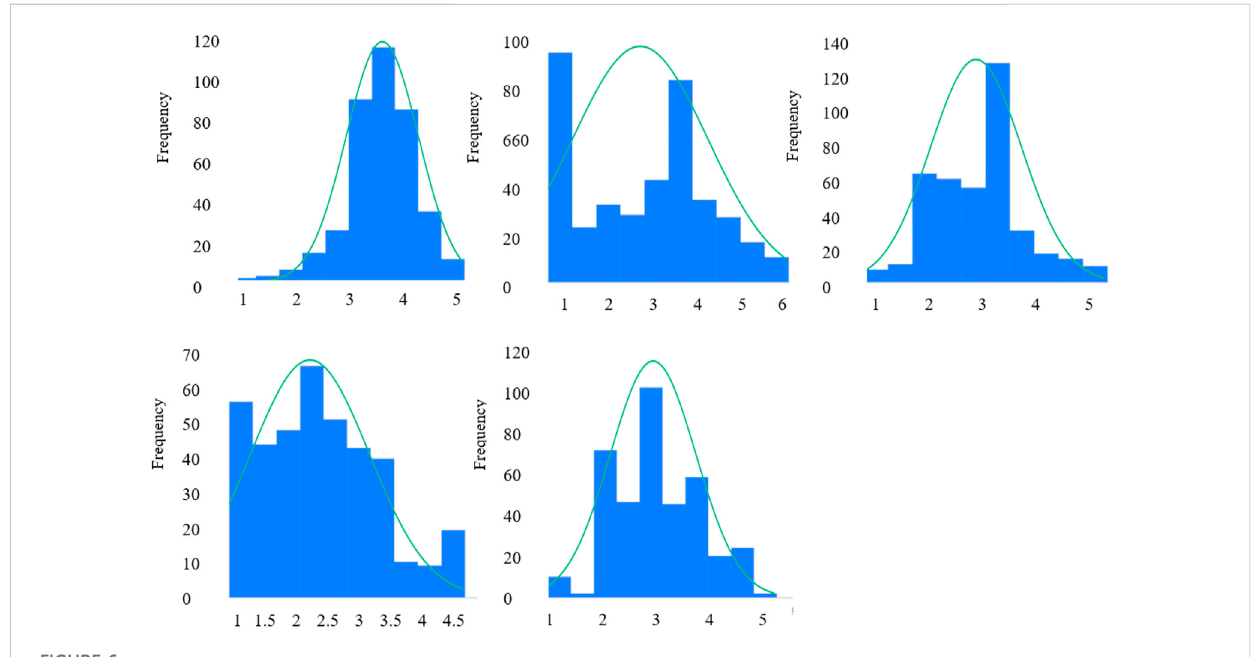
FIGURE 6 Normality test histograms for different genders.